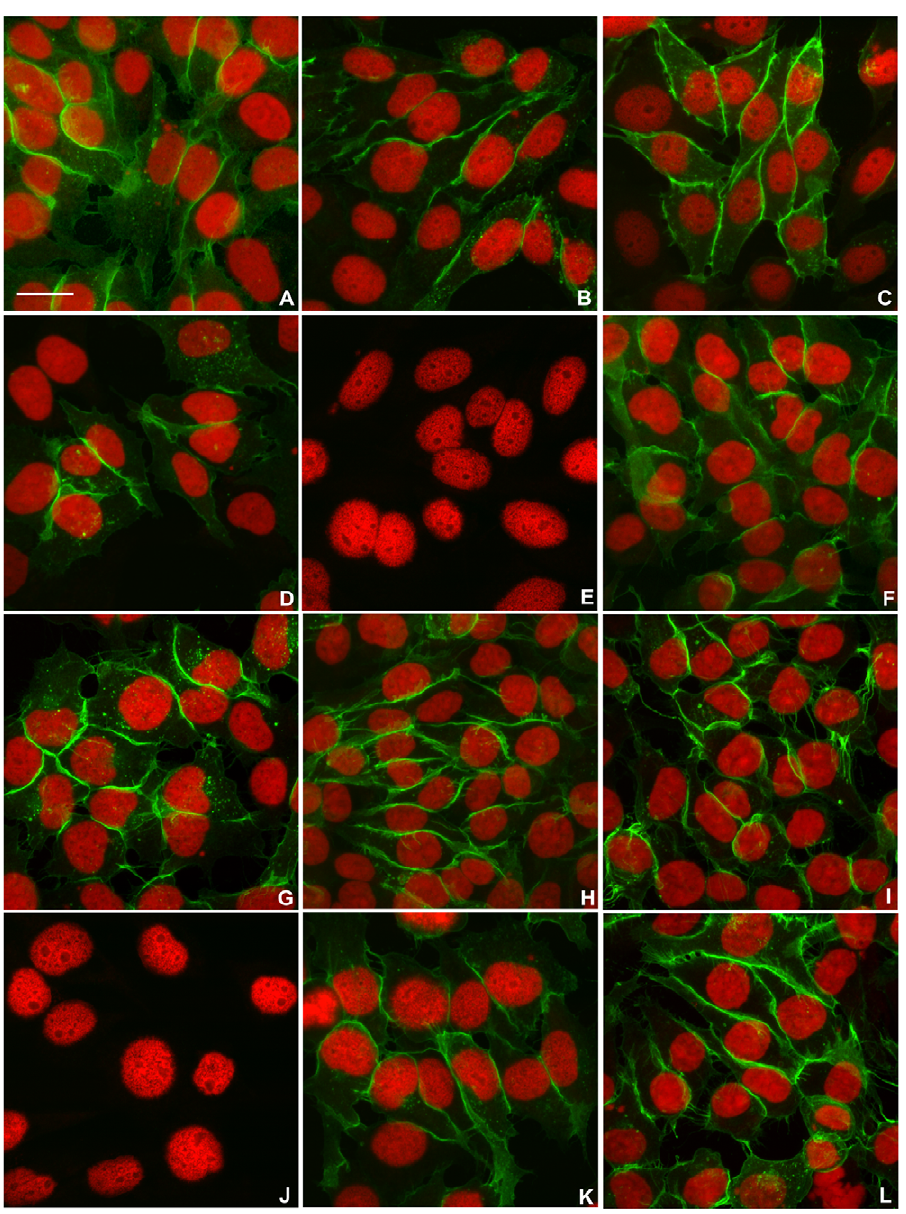
Figure 2. Cell Surface Expression of CEACAM1-4S. 253T-NT cultures stably transfected with wild type or mutated forms of CEACAM1-4S were labeled by indirect immunofluorescence with MAb 9.2, a monoclonal antibody specific for CEACAM1. Cell nuclei were stained with propidium iodide. Confocal digital images constructed from 7–15 optical sections for each labeled subline are shown in panels A–L. ( A ) wild type CEACAM1-4S; ( B ) G424L mutant; ( C ) G432L mutant; ( D ) G424L and G432L double mutant; ( E ) Empty vector; ( F ) Y445V mutant; ( G ) Y448V mutant; ( H ) Y445V and Y448V double mutant; ( I ) G424L, G432L, Y445V, Y448V quadruple mutant; ( J ) untransfected 253T-NT cells; ( K ) G424L, G432L and Y445V triple mutant; ( L ) G424L, G432L and Y448V triple mutant. Scale bar represents 20